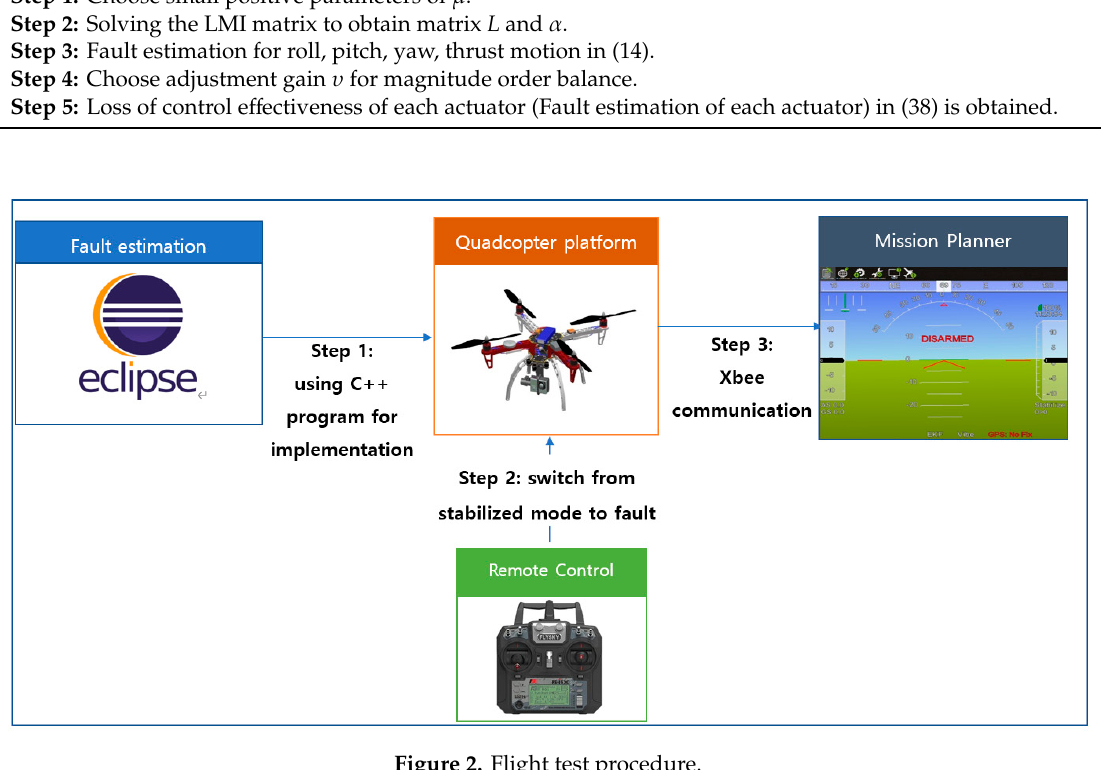
Table 1. Fault estimation procedure. Input: The control inputs and system matrices in (5) satisfying Assumptions 1–4.